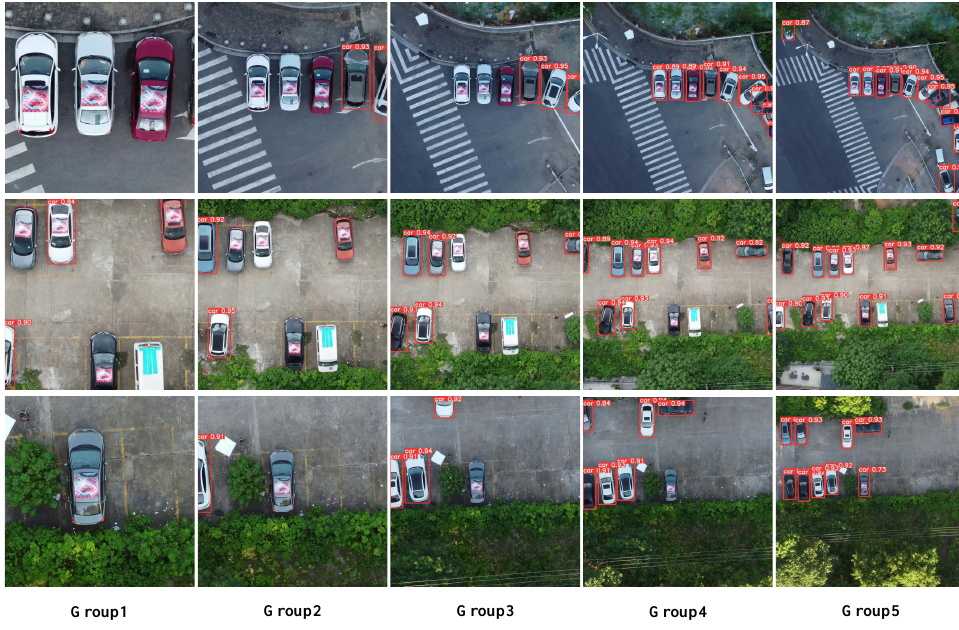
Figure 7. Selected examples of physical attacks on Yolo-V3. These examples are from three scenes, and the images in the same row are from the same scene. For every scene, we select five images from five groups.